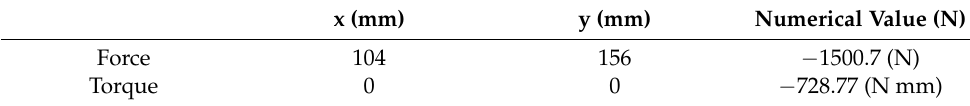
Table 3. Information table of loads.